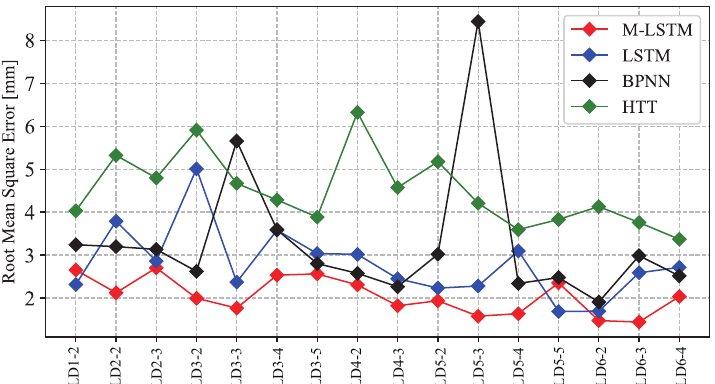
Figure 14. RMSE of each monitoring point based on M–LSTM, LSTM, BPNN, and